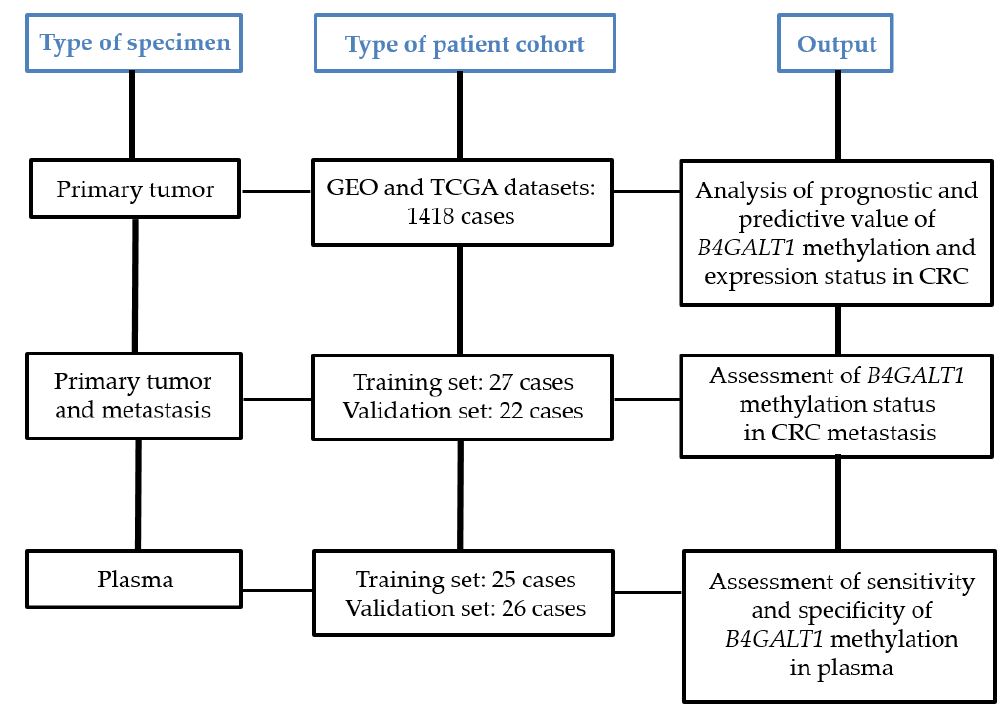
Figure 1. Study design and sample selection workflow.